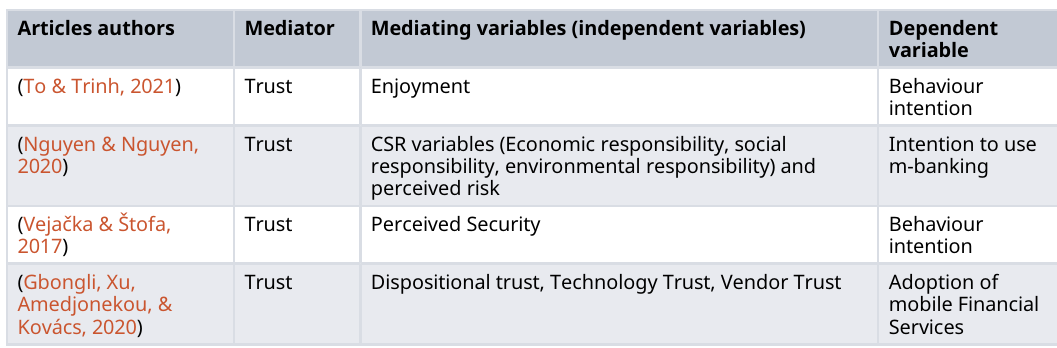
Table 1. Selected articles matching eligibility